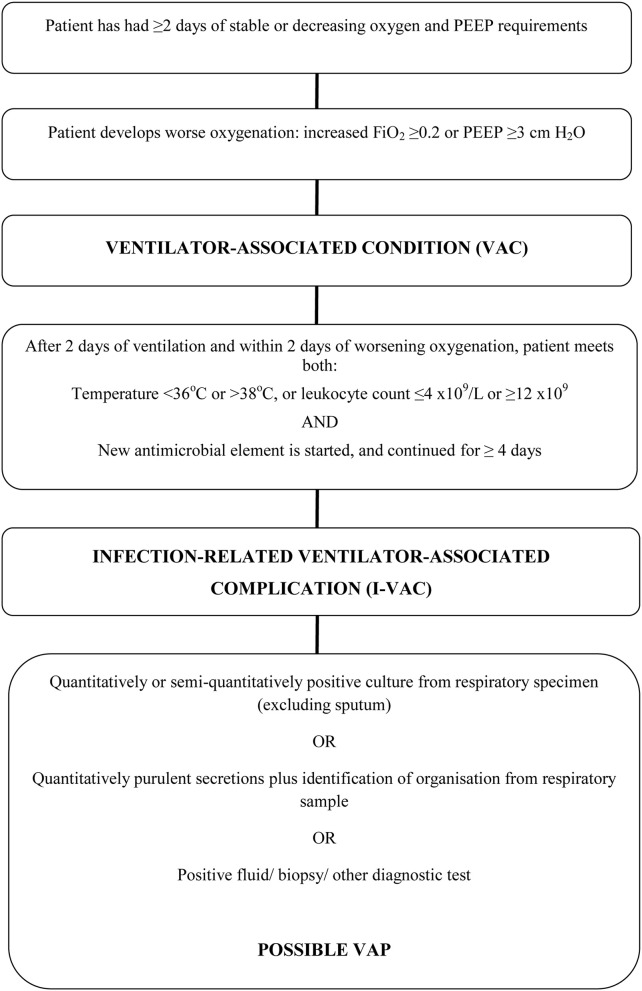
Ventilator-associated events surveillance algorithm. Adapted from Magill (Klompas, 2012).